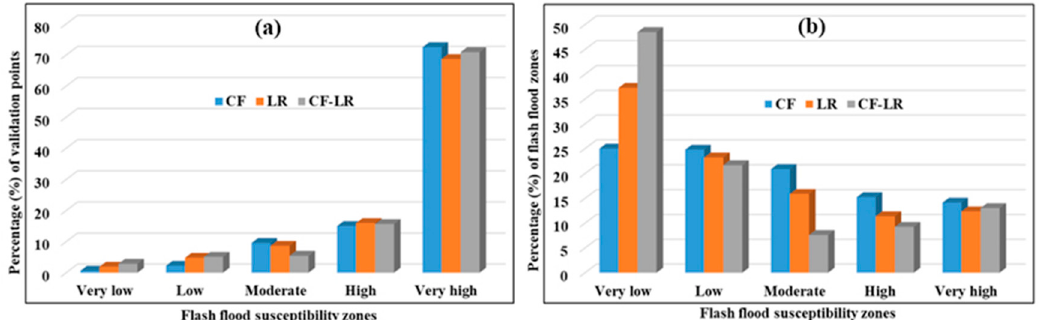
Figure 5. A histogram showing the percentages of ( a ) the validation points and ( b ) the flash flood zones obtained using the three